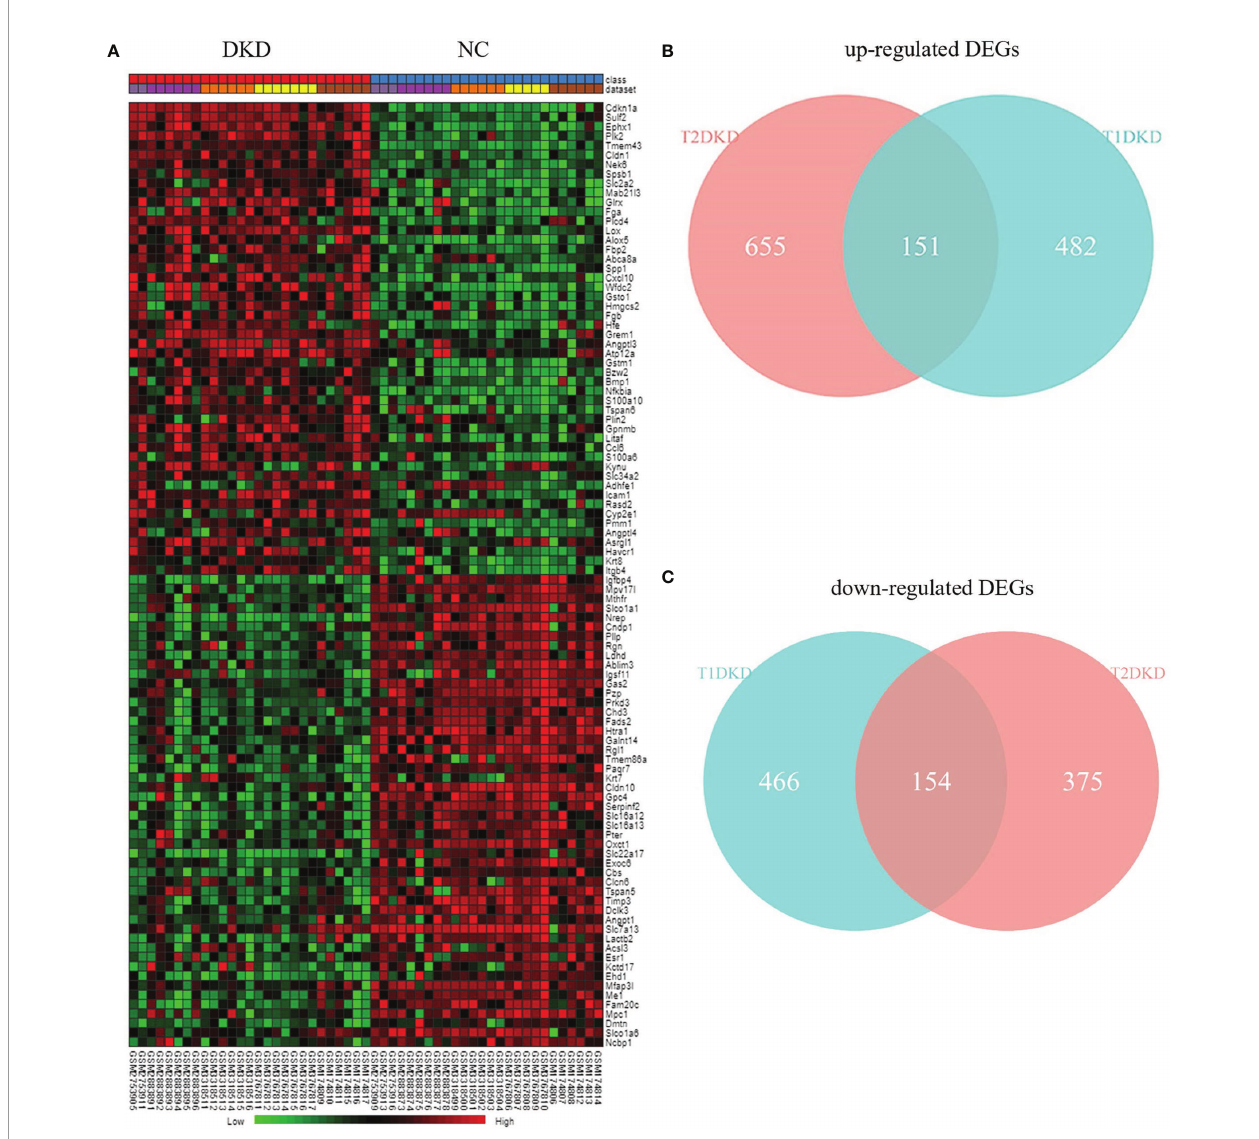
FIGURE 2 | Differentially expressed genes analysis: (A) Heatmap of the top 50 shared up- and down-regulated genes identi fi ed during meta-analysis. (B) Venn diagrams of the shared up-regulated DEGs in TIDKD and T2DKD datasets. (C) Venn diagrams of the shared down-regulated DEGs in TIDKD and T2DKD